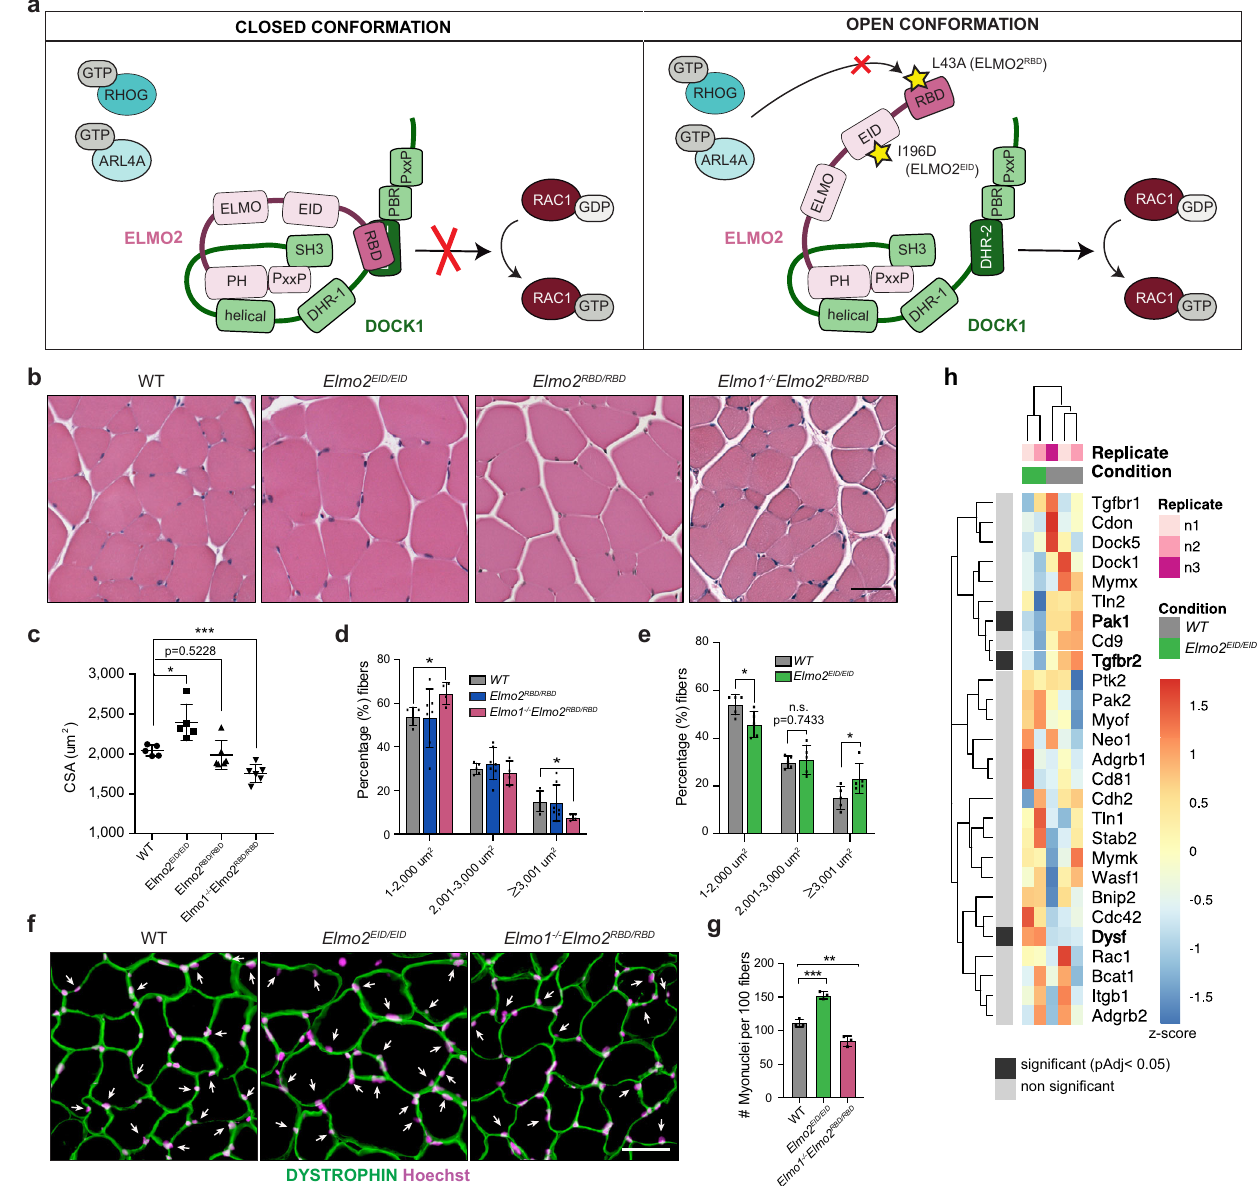
Fig. 2 | Manipulating ELMO2 conformational regulation impacts on myoblast fusion during muscle development and growth. a Schematic representation showing the closed and open conformations of the ELMO-DOCK complex. In the closed state, ELMO is in a closed conformation and the DHR-2 domain of DOCK is blocked by the RBD domain of ELMO, thus preventing RAC1 activation and the binding of interactors to the RBD of ELMO. Upon activation of the ELMO-DOCK complex, binding sites for ELMO interactors become available and the DHR2 of DOCK can activate RAC1. The RBD L43A mutation abrogates the binding of the RHOGandARL4aGTPases,hencediminishingthesignalingfromELMO/DOCK.The EID I196D mutation favors the open conformation of ELMO, which increases RAC1 activation by ELMO/DOCK. b Representative muscle fi bers cross-sections of the indicatedmicestainedwithH&E. c Quanti fi cationof b showingthemeanmyo fi bers cross-sectional area (CSA) +/ − SD per genotype ( n =5 mice). d , e Distribution of myo fi bers size from ( b ) of the indicated mice. Data are presented as the mean